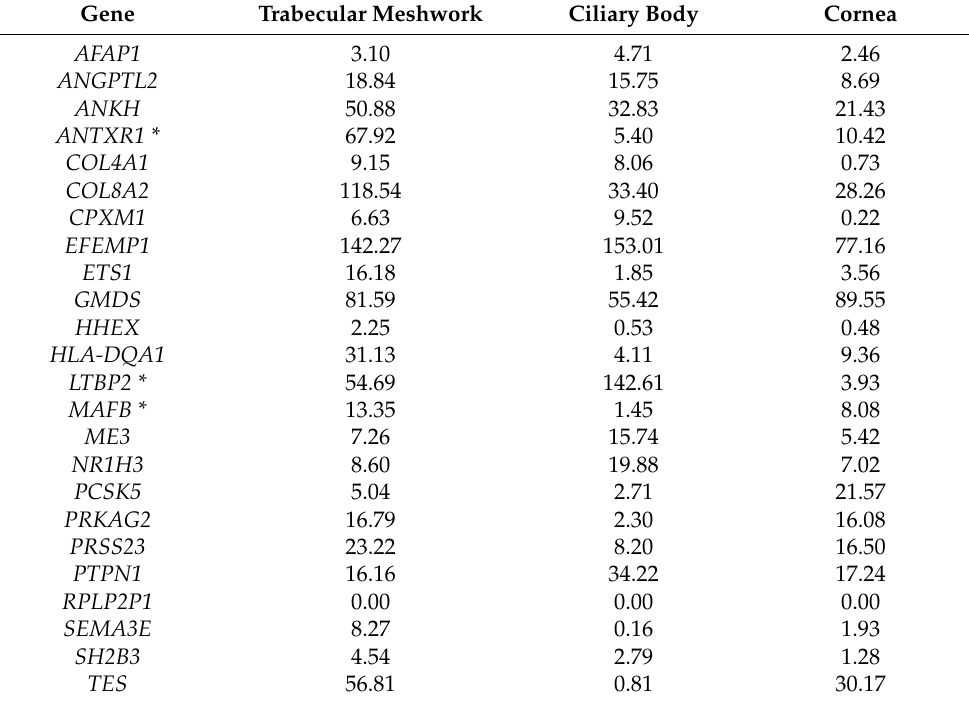
Table 5. Expression (FPKM) of Filtered Intraocular Pressure-Associated Genes in a Previously Published Transcriptional Profile of Adult Human Trabecular Meshwork, Ciliary Body, and Cornea